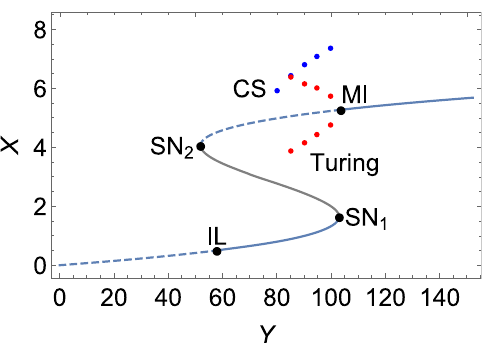
Figure 5: Stationary homogeneous solution (solid and dashed lines), cavity soliton branch (blue symbols), and Turing pattern branch (red symbols) for Eq. (3). Δ = 2.5, G = 2.5, θ = 12 (point b of Figure 3), and η max =